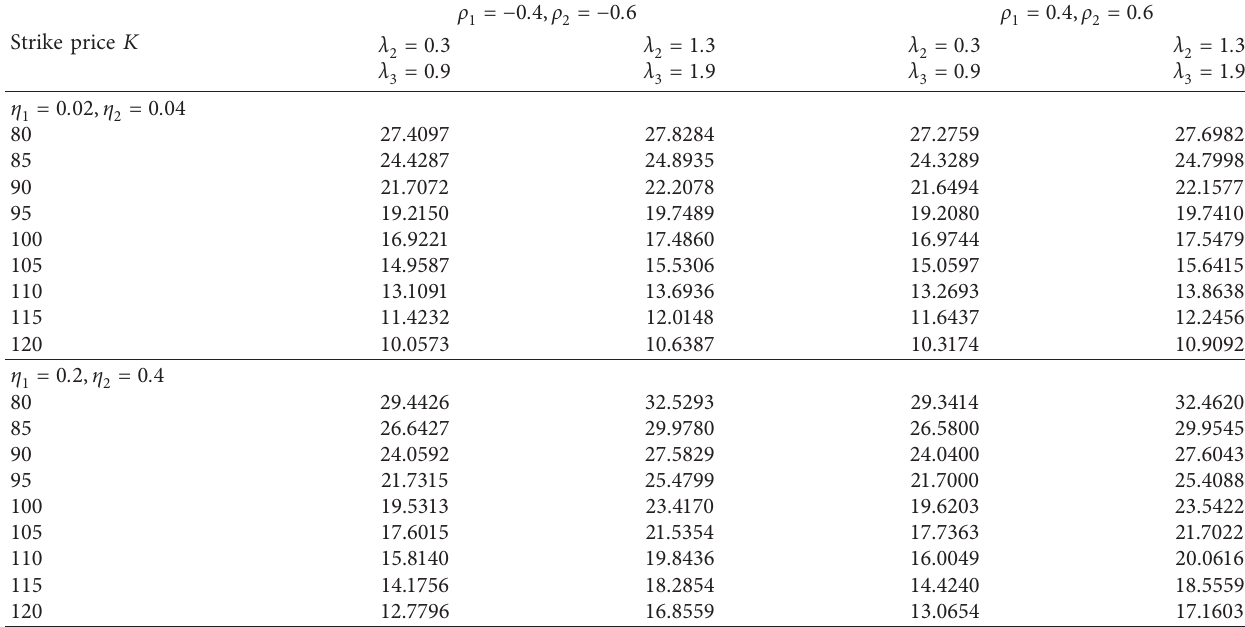
, λ , η , η , and ρ 2 3 1 2